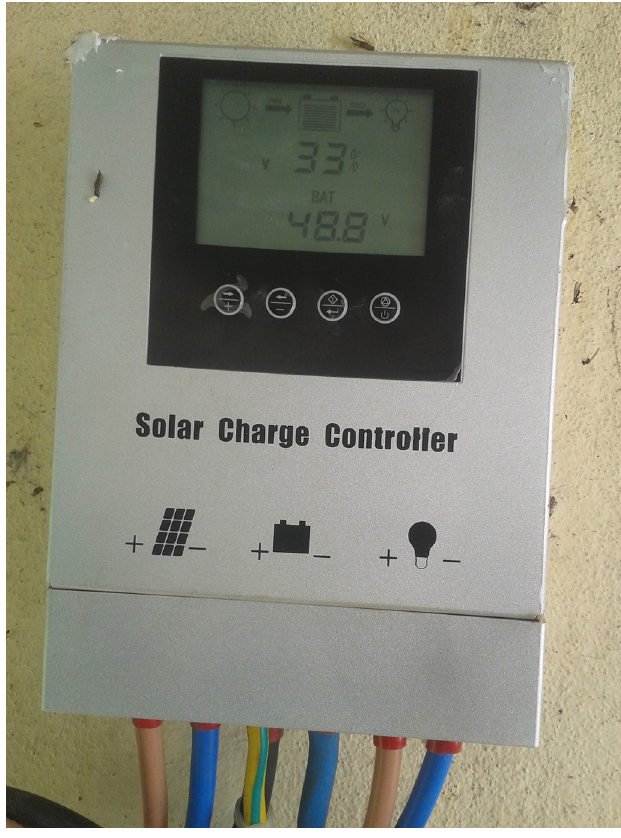
Fig. 11. Unbranded solar charger for the national telecommu- nication company station at Mengong (cid:1) Cameroon (Photo J.